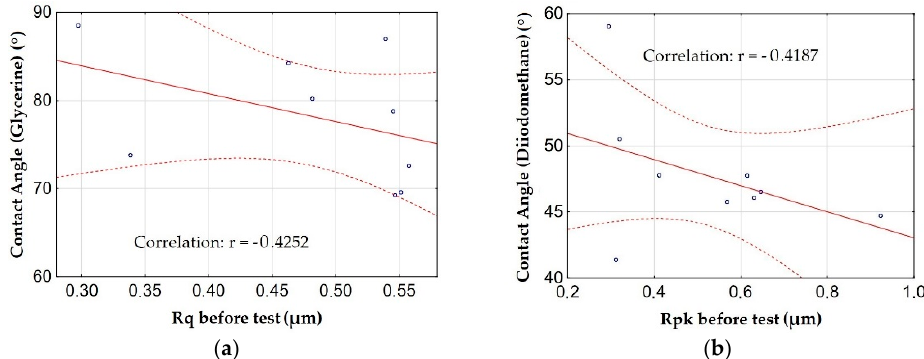
Figure 18. The relationship between the contact angle: ( a ) measured by glycerin and the Rq parameter before the test, ( b ) measured by diiodomethane and the Rpk parameter before the test. The contact angle measured by glycerin and diiodomethane was found to be related to the amplitude parameters and the load capacity curve. There is a moderate correlation (significant relationship) between the contact angles for glycerin and diiodomethane and the Rq and Rpk parameters. The correlation is negative, which means an increase in con- tact angles with a decrease in Rq and Rpk parameters, similar to the measurements by water. Table 8 shows the values of surface free energy (SFE) calculated using the Owens– Wendt method using the contact angles for distilled water and α -bromonaphthalene.